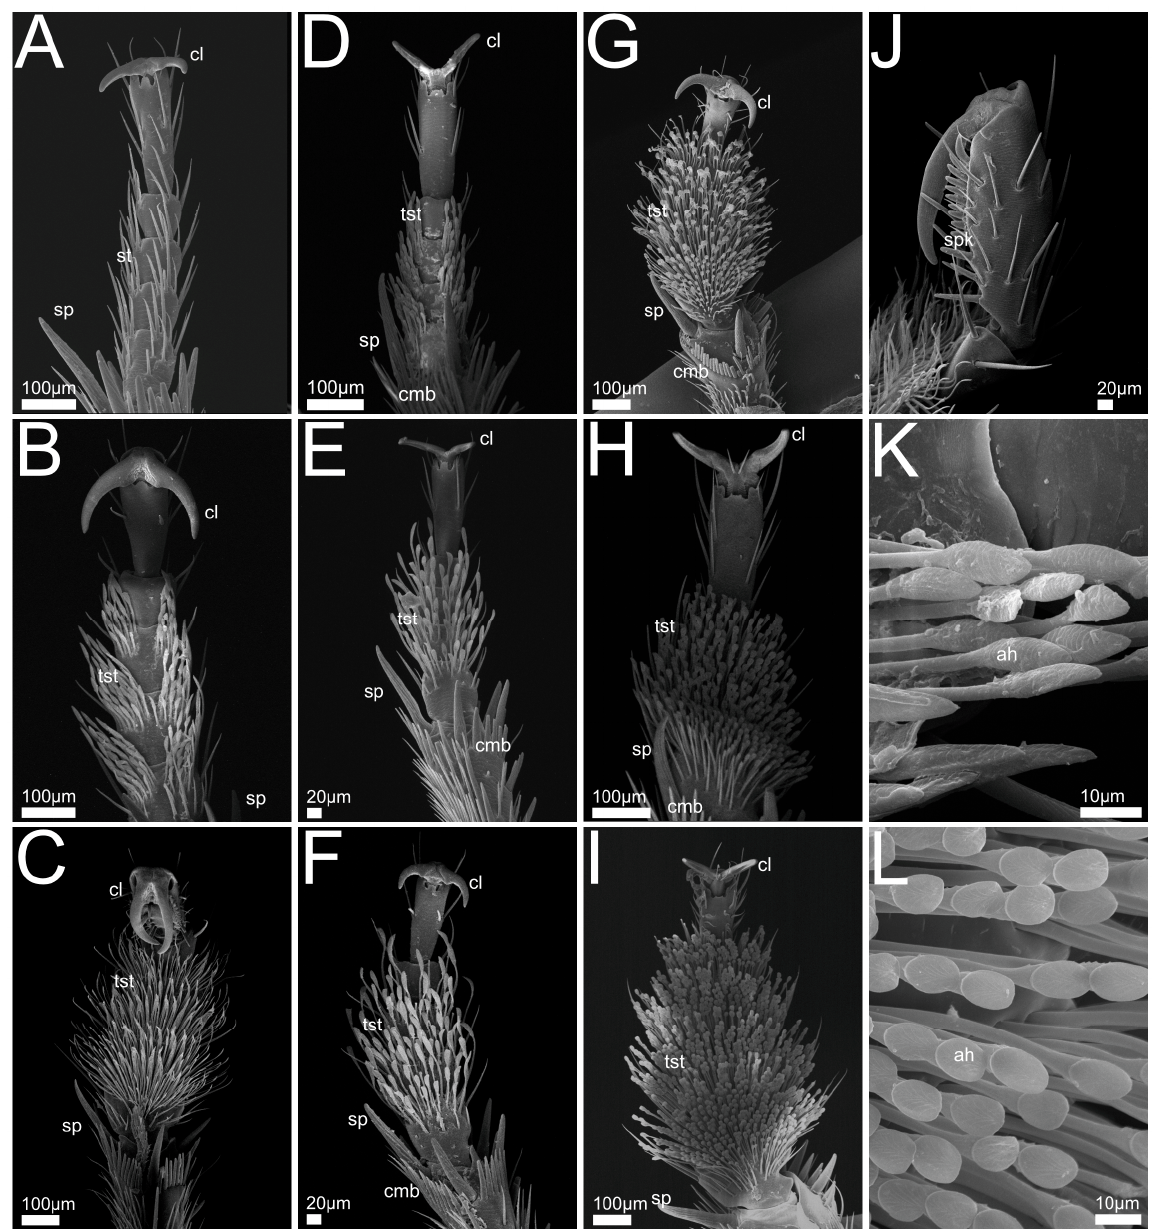
Figure 4. SEM views of Staphylinini front legs. Images A – I , ventral view of claw, tarsomeres and end of tibia (left front leg), J – L with detailed views of adhesive setae and claw, ( A ) Bisnius sordidus (female); ( B ) Philonthus varians (female); ( C ) P. marginatus (male); ( D ) P. rufipes (female); ( E ) P. discoideus (male), ( F ) P. alpinus (male); ( G ) Quedius cinctus (male); ( H ) Q. cruentus (female); ( I ) Q. curtipennis (female); ( J ) P. marginatus (male), lateral view of claw (left front leg); ( K ) P. varians (female), adhesive setae on ventral tarsomere surface (left front leg); ( L ) Q. cruentus (female), adhesive setae on ventral tarsomere surface (left front leg). Abbreviations: ah: adhesive spatulate head; tst: tenent setae; cl: claw; cmb: comb-like structure; sp: spur; spk: spikes; st: setae (non-adhesive); tst: tenent setae.